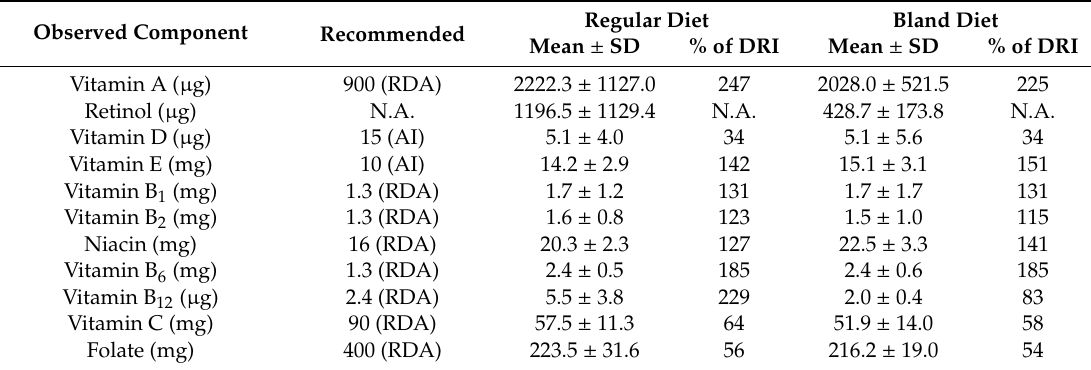
Table 3. Vitamins provided in prisons ( n = 30) menus per person per day and the age-specific dietary reference intake